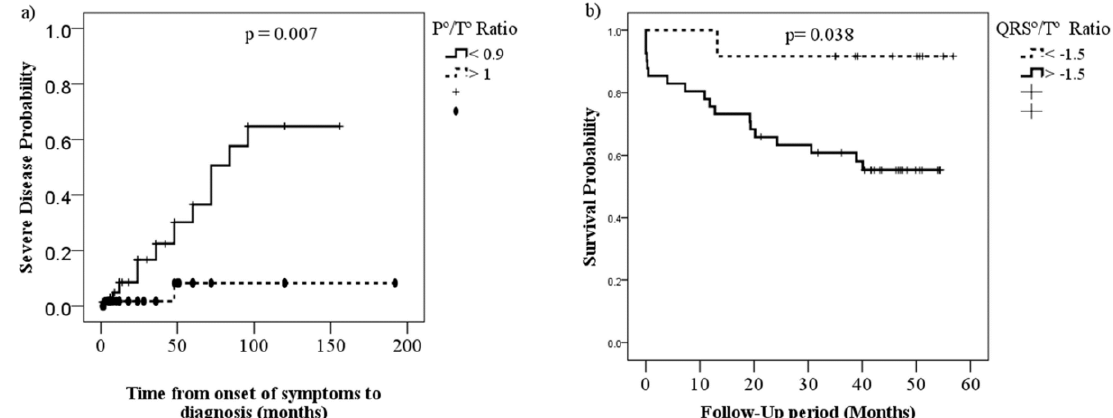
Figure 2. Kaplan–Meier curves comparing severity ( a ) and survival ( b ) proportions of patients with PH by P ◦ /T ◦ ratio (<0.99 vs. >1.0) and QRS ◦ /T ◦ ratio (< − 1.5 vs. >1.5), respectively.